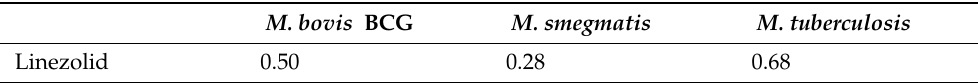
Table 3. FICI (fractional inhibitory concentration index) values obtained for linezolid with compound 1 against M. bovis BCG, M. smegmatis , and M. tuberculosis H37Rv. The values were obtained in three independent